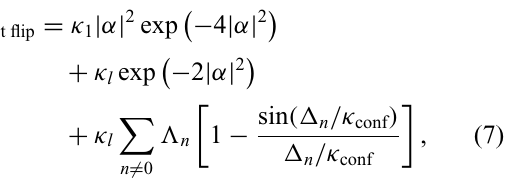
(cid:13) bounded. Figure 5(b) shows the asso- n ciated relative overlap between a cat-qubit state deformed by leakage and the n th pair of TPE